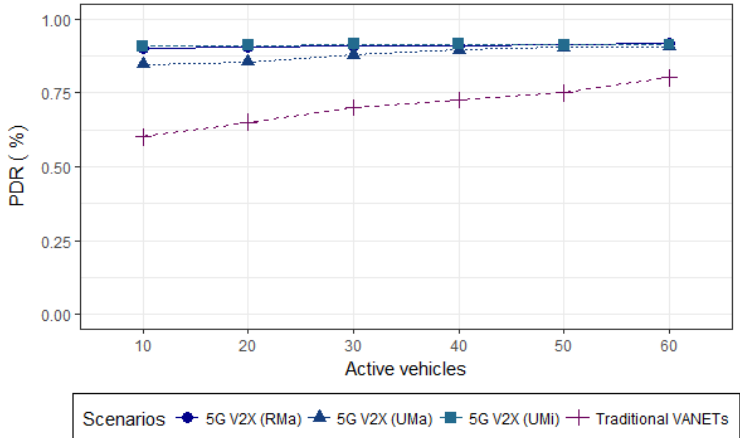
Figure 9. Packet Delivery Ratio in 5G V2V